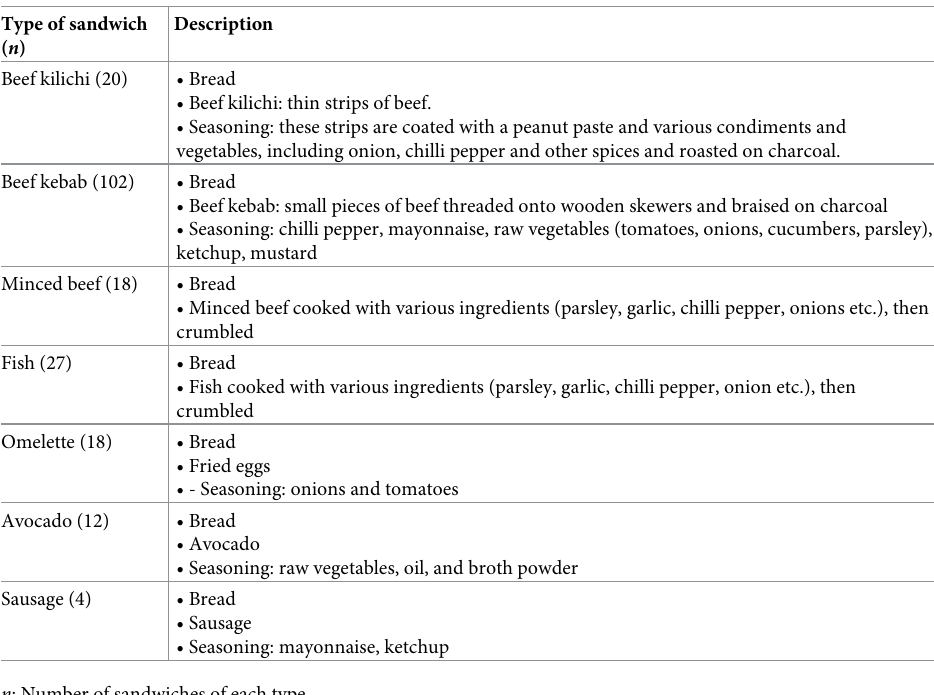
Table 1. Composition of the sandwiches